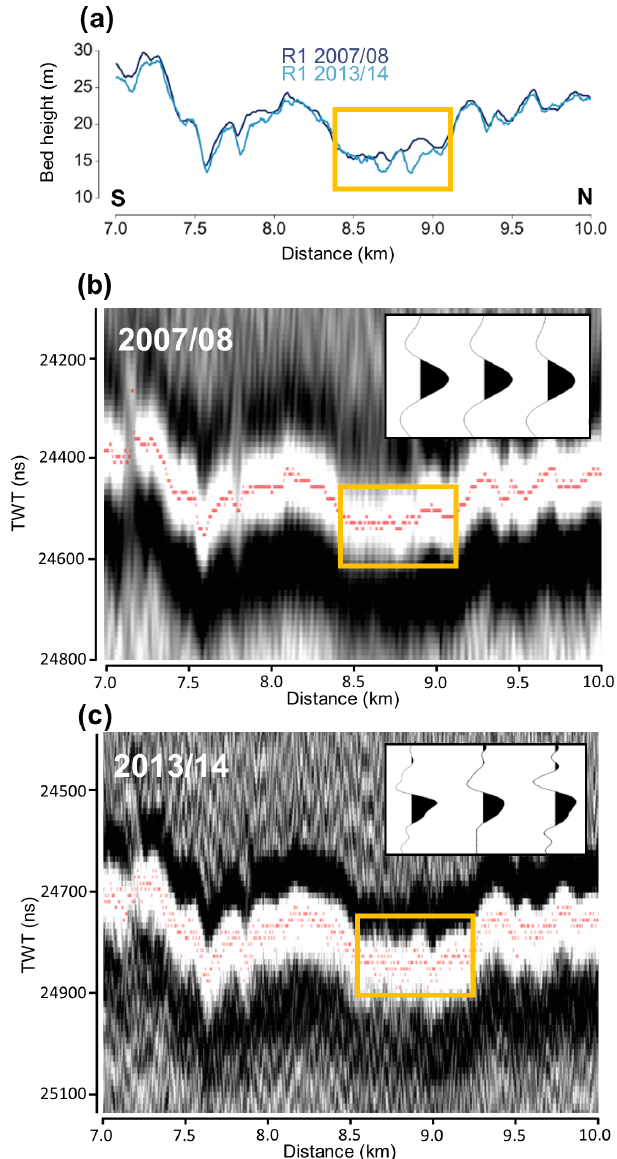
Figure 5. Close-up view of change in bed morphology between 2007/2008 and 2013/2014 identified in survey R1. Yellow boxes outline the area of change identified as having a low correlation ( r = − 0.2). (a) Smoothed bed picks from radar data. (b, c) Raw bed picks (red dots) of the basal reflector in 2007/2008 and 2013/2014. Inset plots show representative traces sampled from the bed reflec-